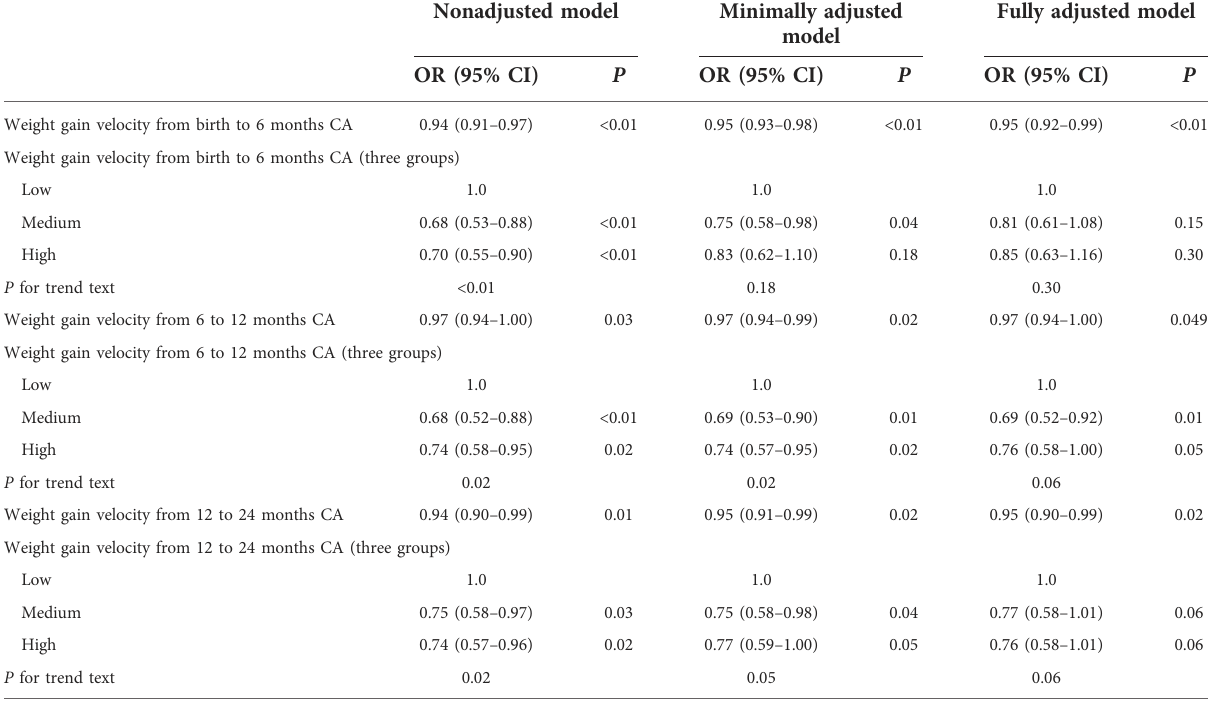
TABLE 2 Results of univariate and multivariate analysis.